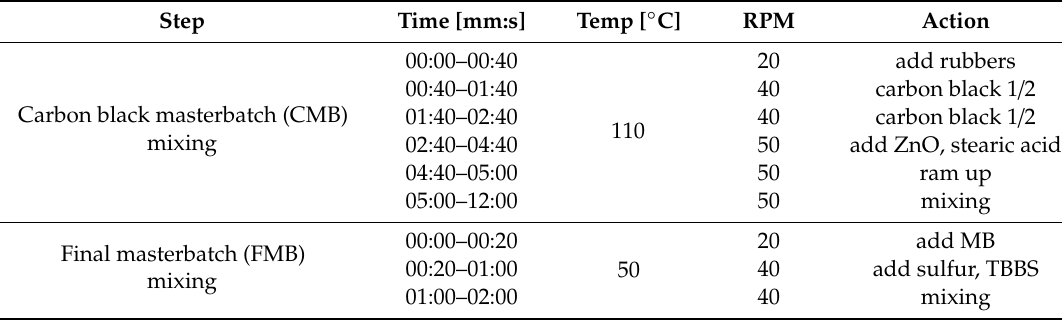
Table 4. Mixing procedure for the carbon black-filled compounds.